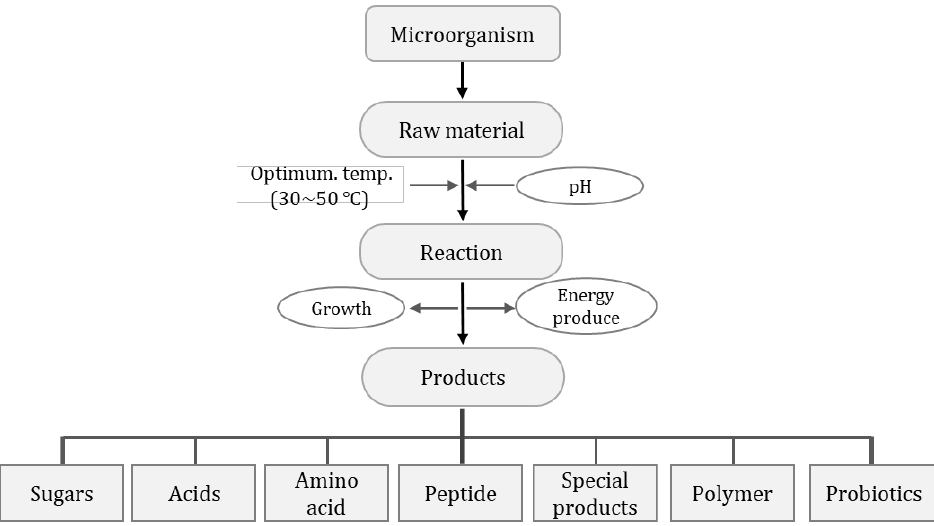
Figure 1. Enzymes released by microorganisms and the enzymes of the raw material.